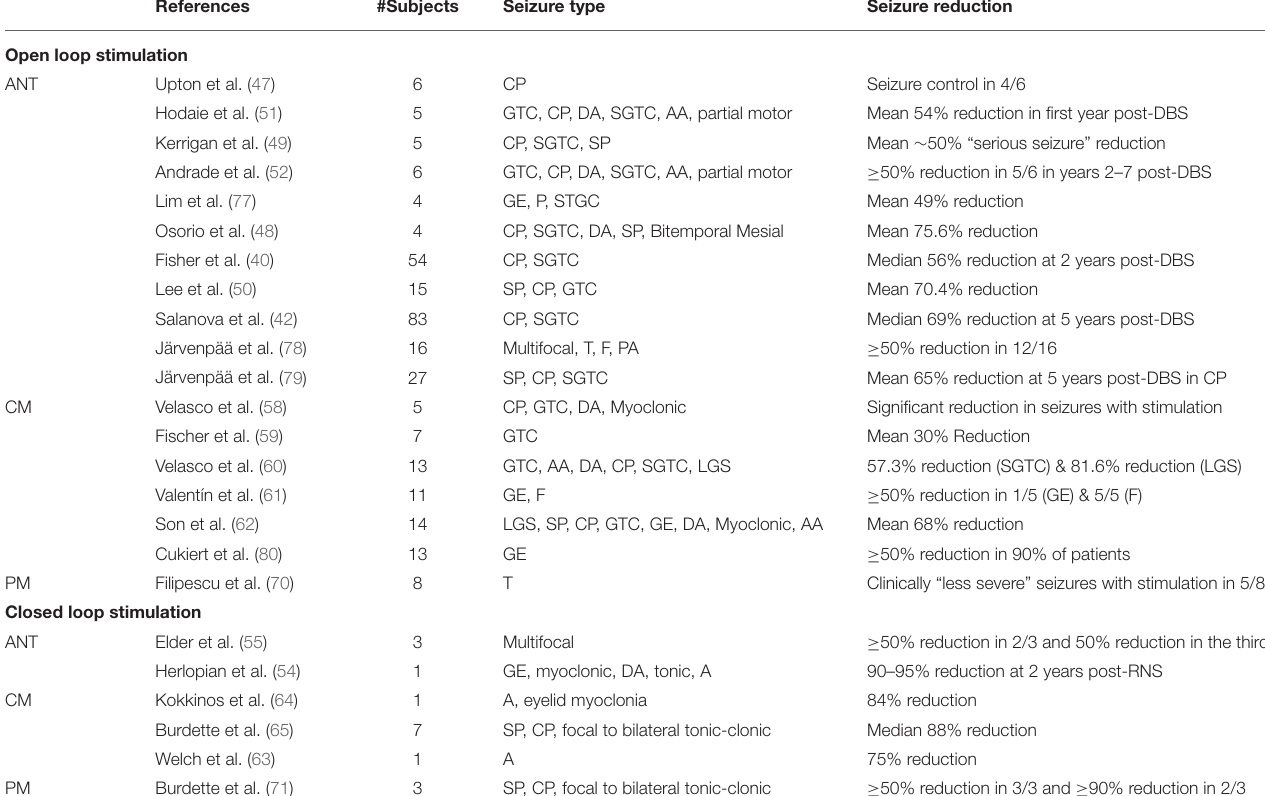
TABLE 1 | The effect of open and closed loop stimulation on seizure